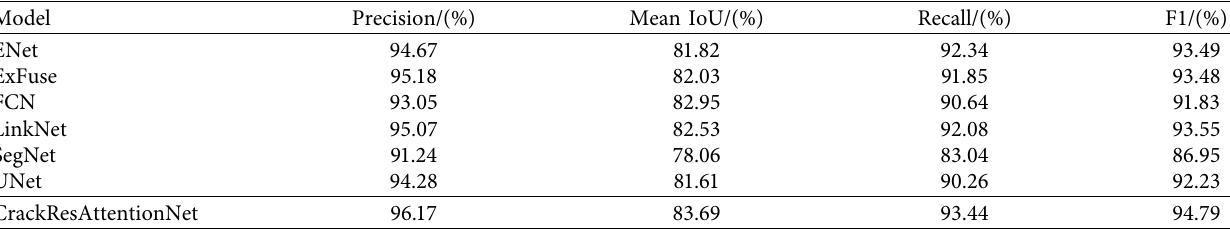
Table 7: Yantai Dataset–BCE